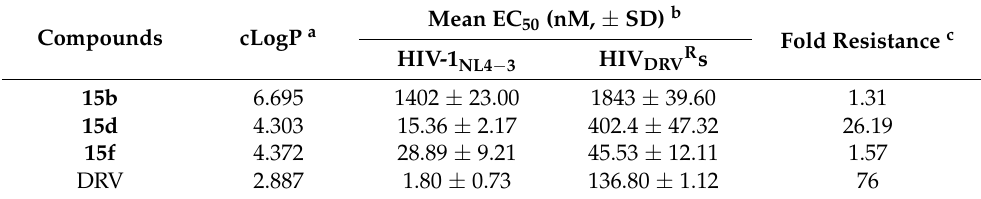
Table 3. Antiviral activity of 15b , 15d , and 15f against multidrug-resistant HIV-1 variants.